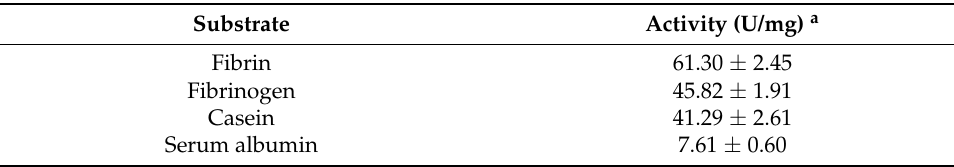
Table 3. Determination of substrate specificity of